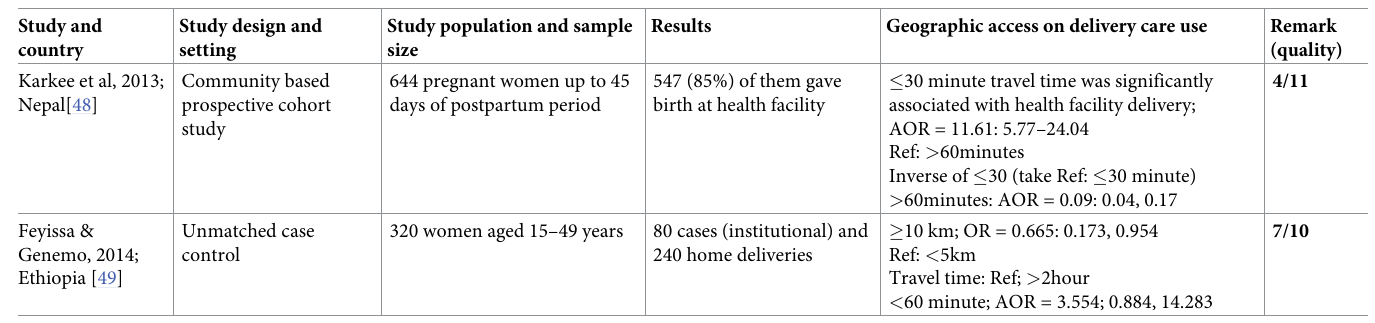
PLOS ONE | https://doi.org/10.1371/journal.pone.0203130 August 30,